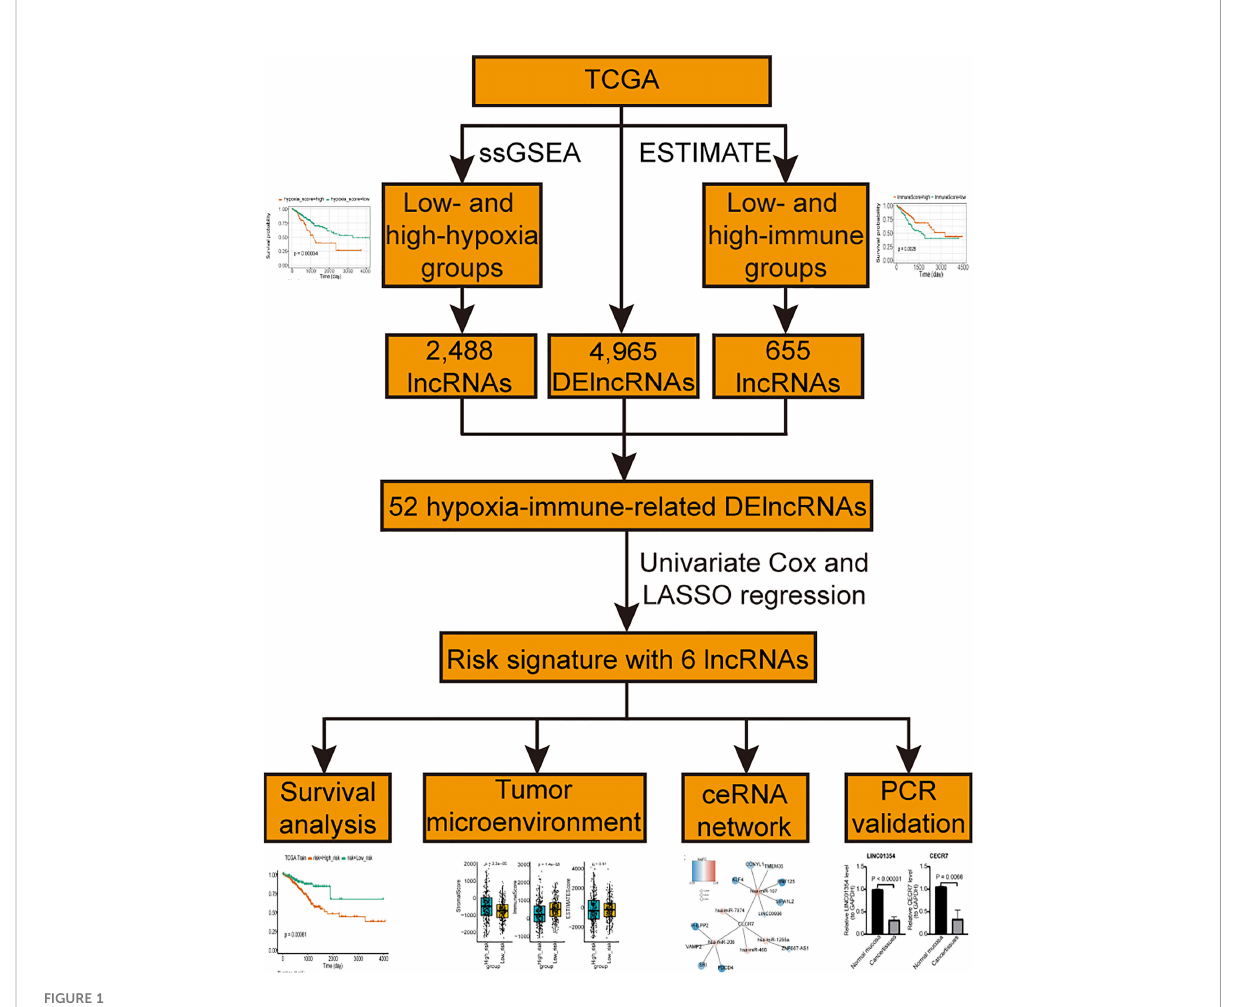
FIGURE 1 The fl owchart of the steps involved in this